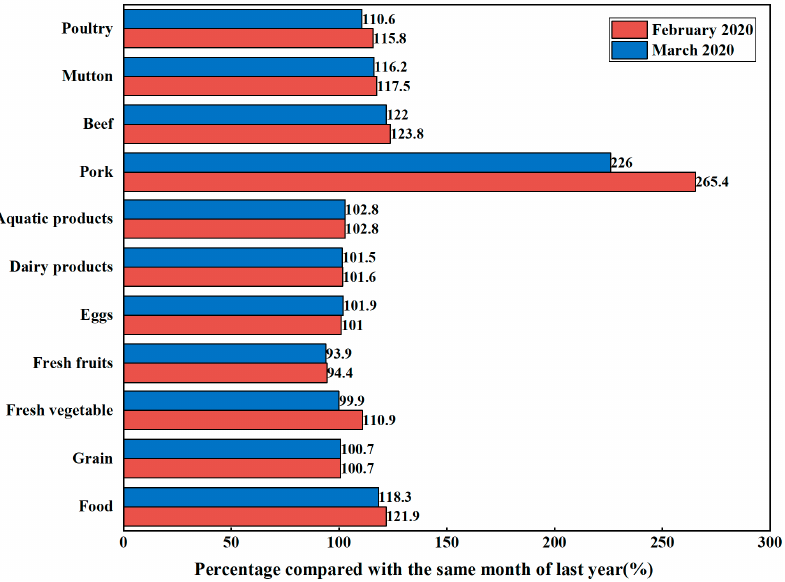
Figure 3. Percentage compared with the same month of the previous year (same month of previous year = 100%). Note: The values of food, grains, fresh vegetables, fresh fruits, eggs, and aquatic products are the percentage of consumer price index compared with the same month of the previous year. The value of dairy products is the percentage of producer price index compared with the same month of the previous year. The values of pork, beef, mutton, and poultry are the percentage of market price compared with the same month of the previous year. The data in the figure are from the National Bureau of Statistics.